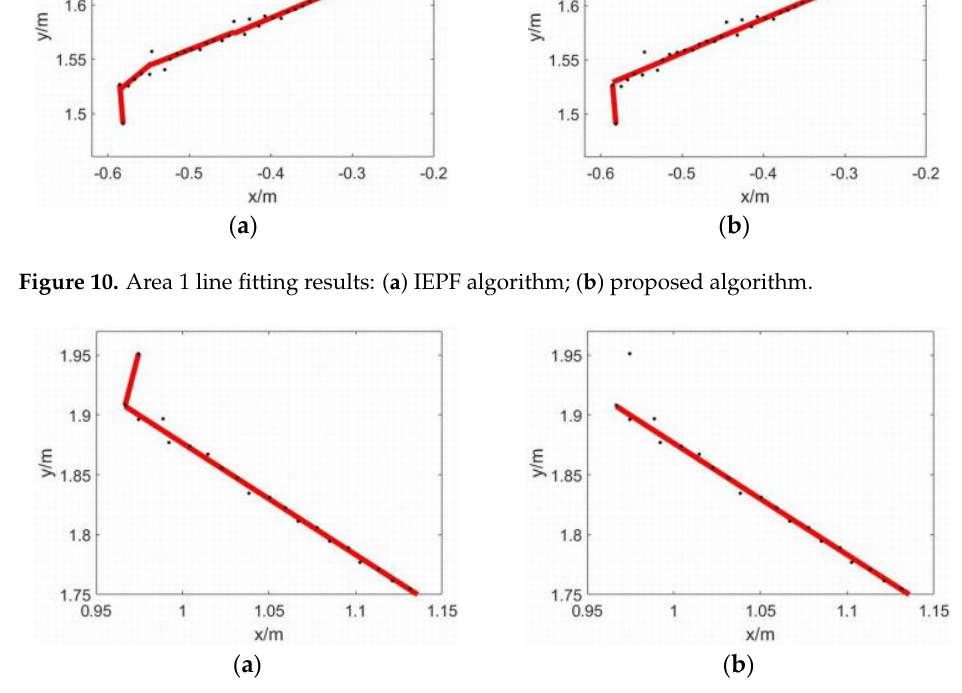
Figure 12. Area 3 line fitting results: ( a ) PDBS algorithm; ( b ) proposed algorithm.